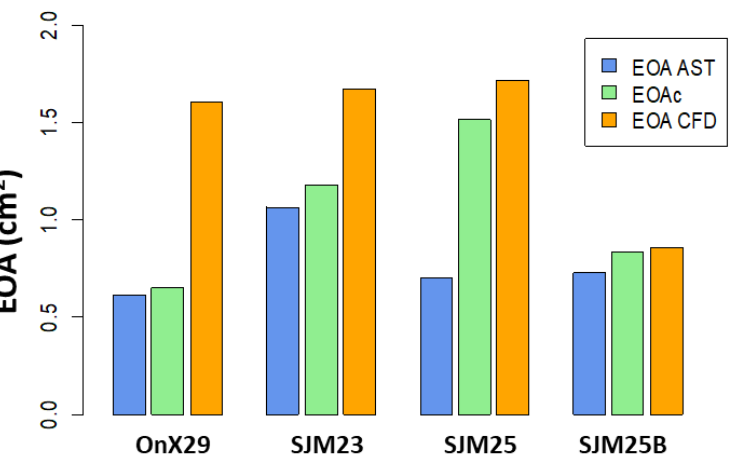
Figure 6. Comparisons of EOA for the four models of BMHV using MRI data (EOA AST —blue and EOA C —green) and comparison with the numerical results EOA CFD